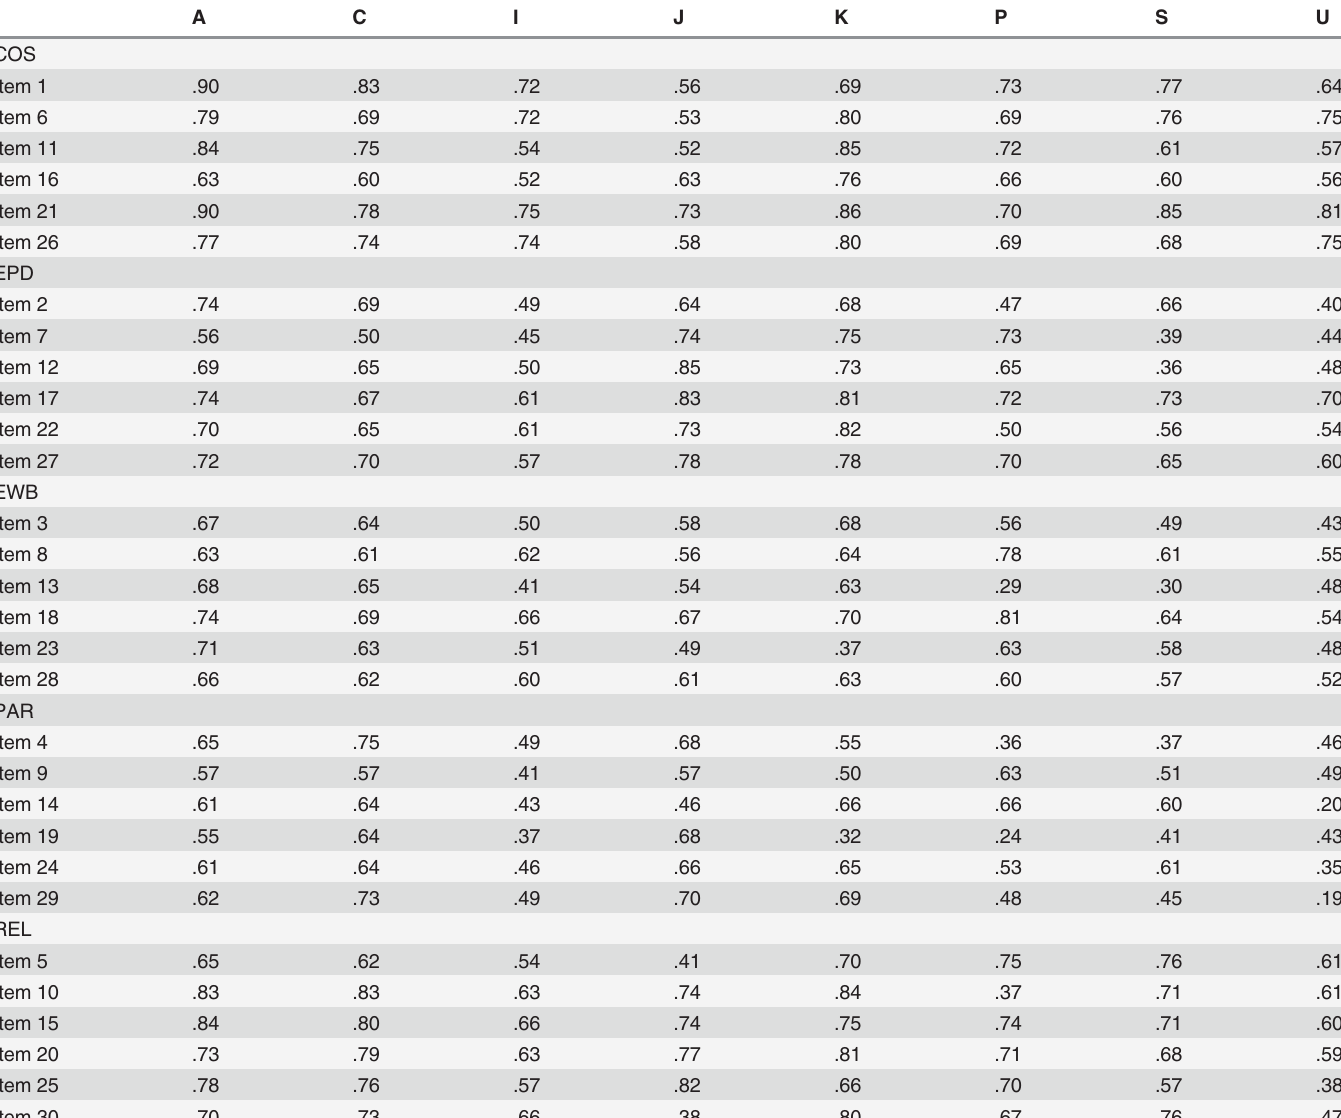
Table 15. Standardized Regression Weights for All Country Samples from Simultaneous Multiple Group CFA of Five Factor ESI-R Model with all Parameters Freely